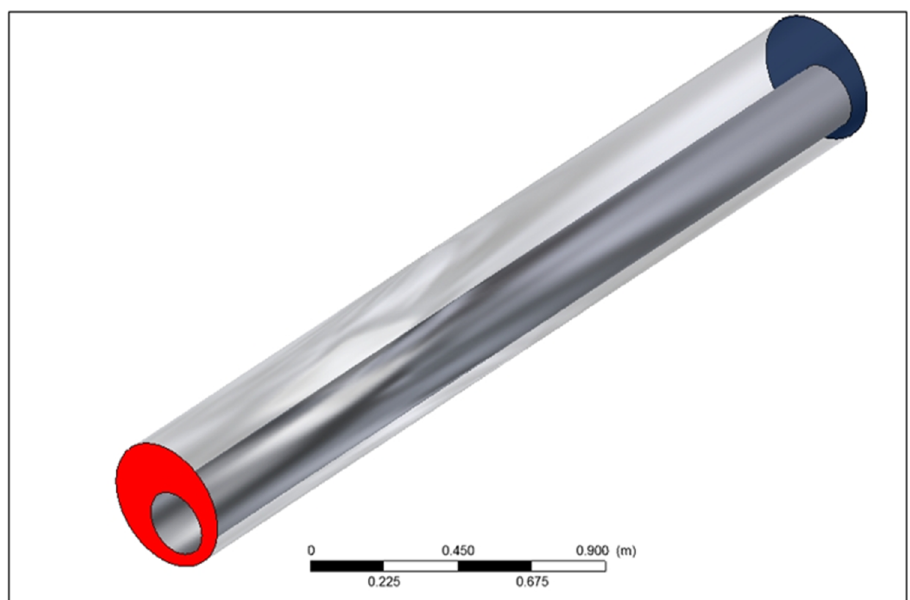
Fig. 3 Annulus-drill string geometry created for eccentric mode